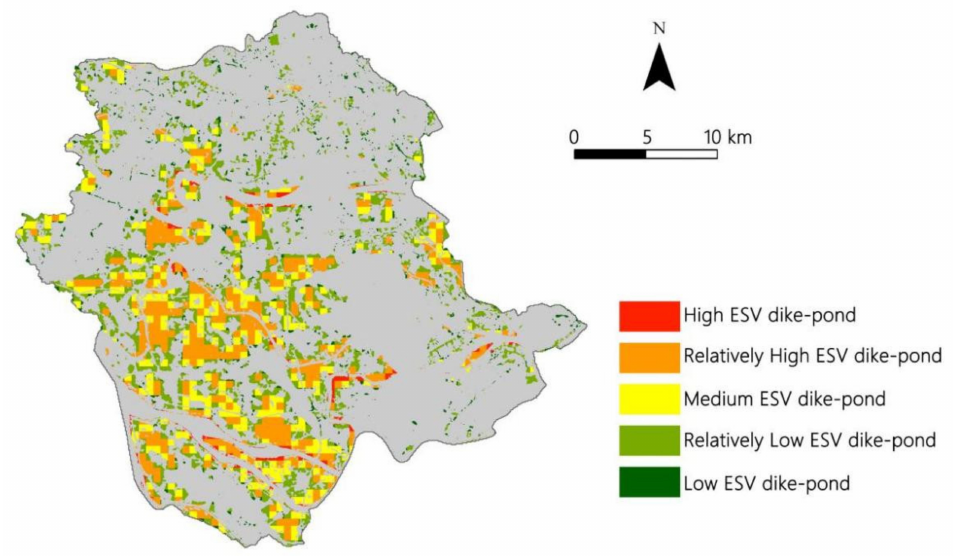
Figure 10. Spatial distribution of dike-pond ESVs in